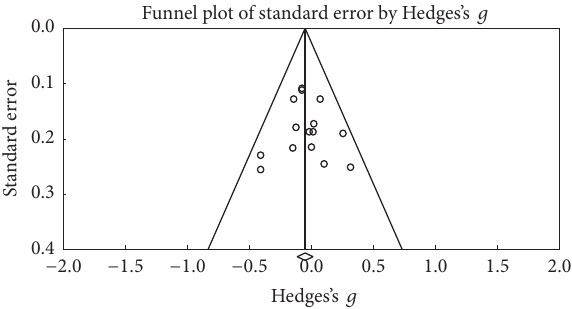
Figure 14: Funnel plot for standard error in publications of Digit Span Test